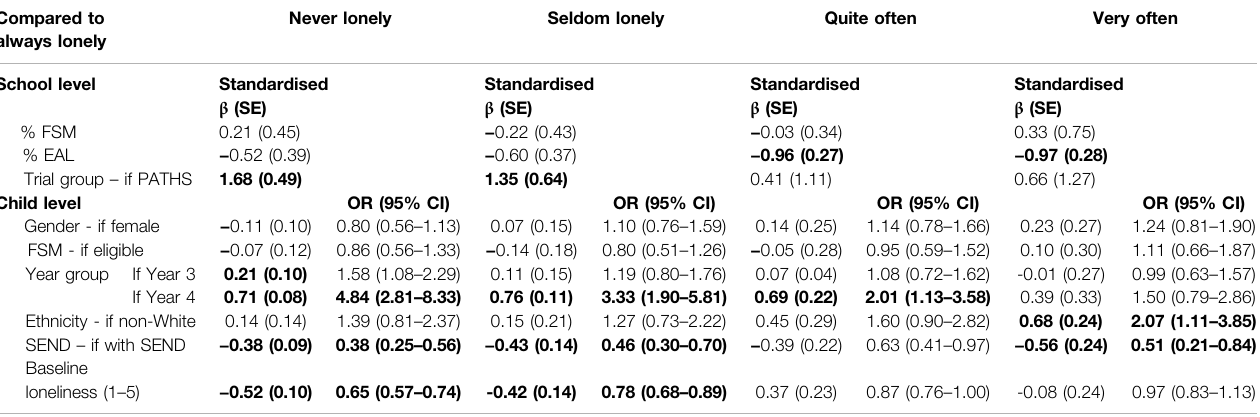
TABLE 3 | Hierarchical multi-nomial regression models of the impact of PATHS curriculum on loneliness. Compared to Never lonely Seldom lonely Quite often Very often always lonely School level Standardised Standardised β (SE) β (SE)